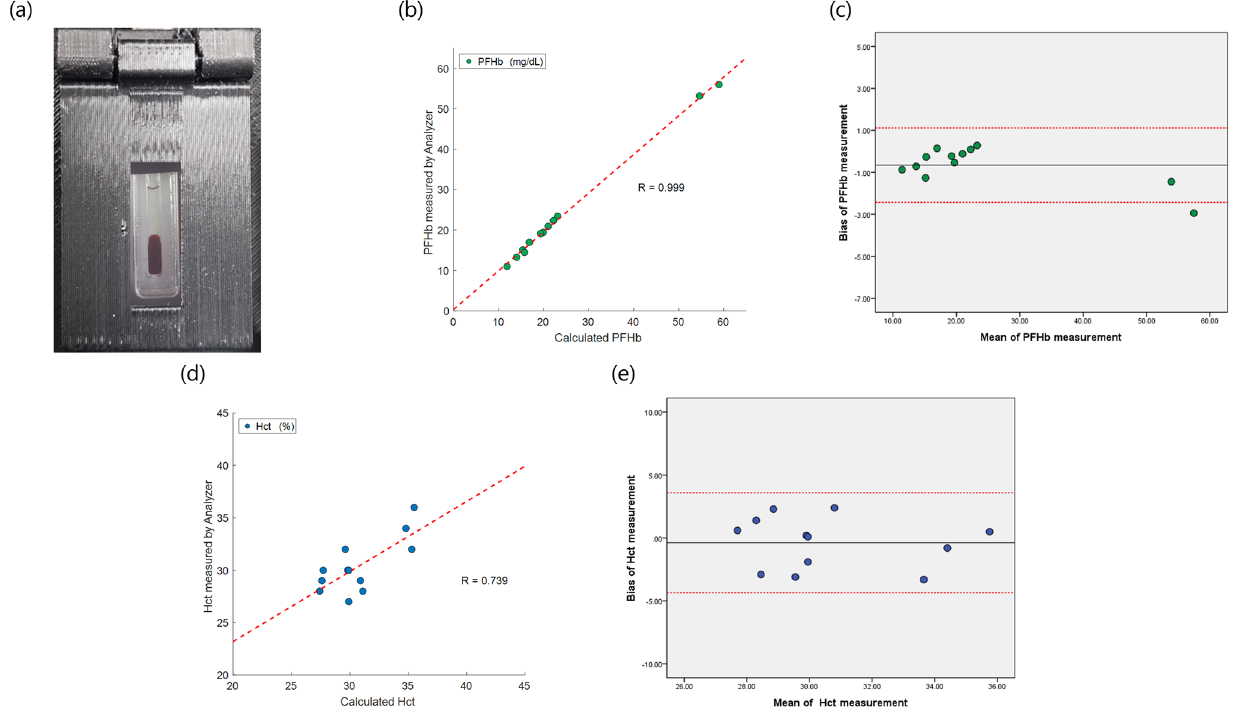
Figure 4. In vitro validation of the hematological analysis during in vivo study of the Venous-arterial extracorporeal membrane oxygenation (VA-ECMO) system using swine model. ( a ) Obtained image from the camera module after centrifugation. ( b – e ) Comparison results between our device and lab test results. ( b ) Linear regression analysis of PFHb levels with slope of 0.958, intercept of 0.366, and R of 0.999. ( c ) Bland– Altman analysis of PFHb levels, showing a mean bias of − 0.38 mg/dL and a 95% confidence interval of (− 2.44 to 1.12) mg/dL. ( d ) Linear regression analysis of Hct levels with slope of 0.669, intercept of 9.812, and R of